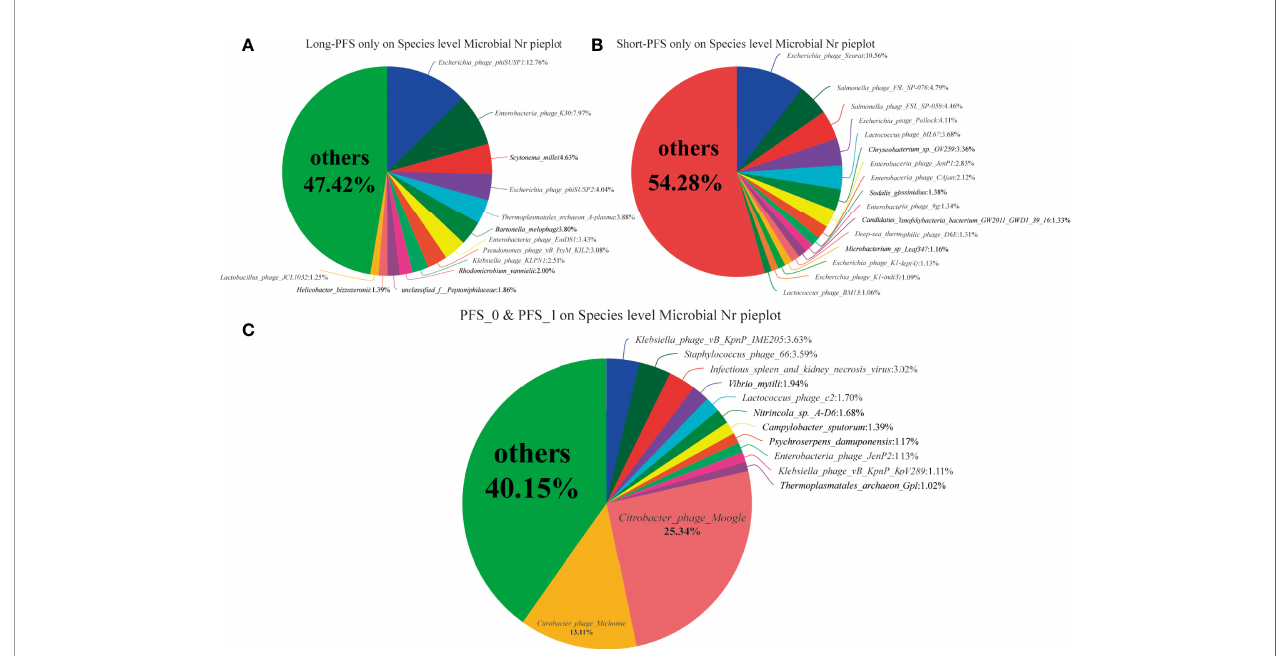
FIGURE 2 | (A – C) The communitypieanalysisatspeices levelonlyonlong-PFSgroup, onlyonshort-PFSgroupand